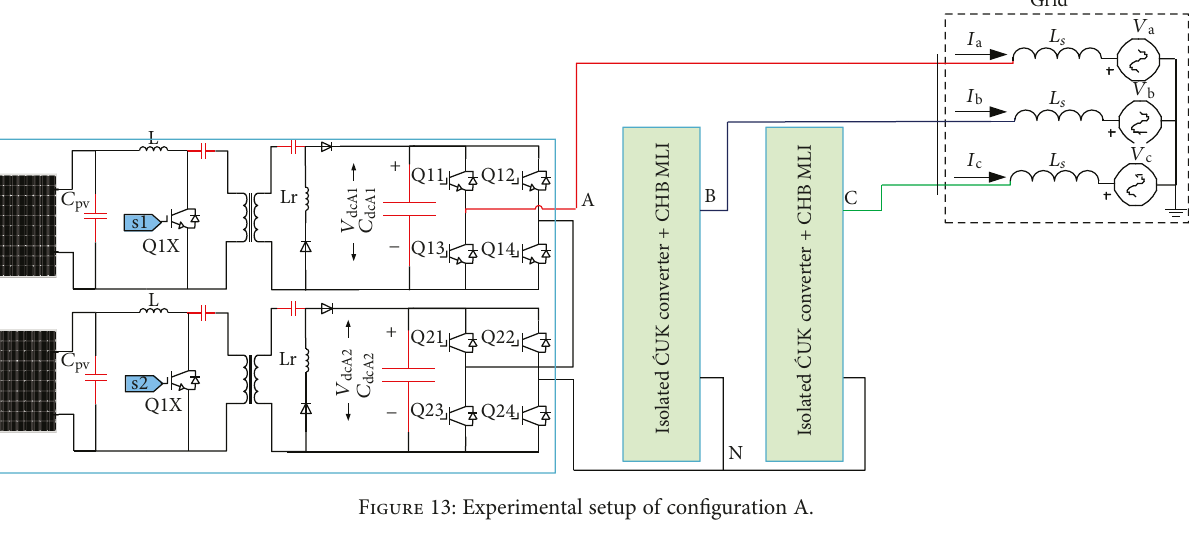
Figure 13: Experimental setup of con fi guration A.